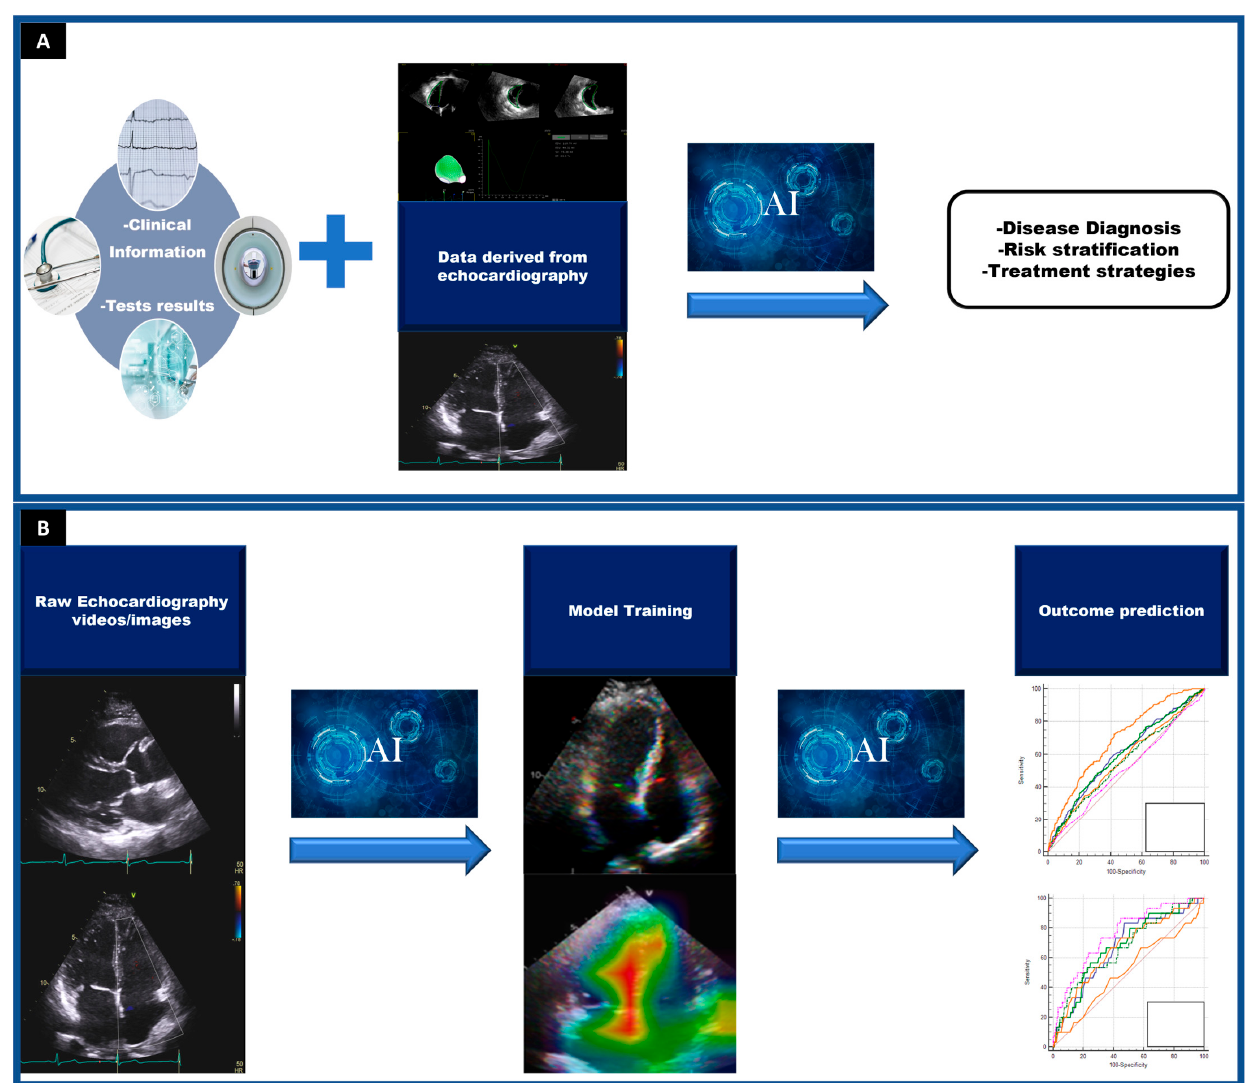
Figure 1. Different applications of artificial intelligence (AI) in echocardiography. Panel ( A ). One